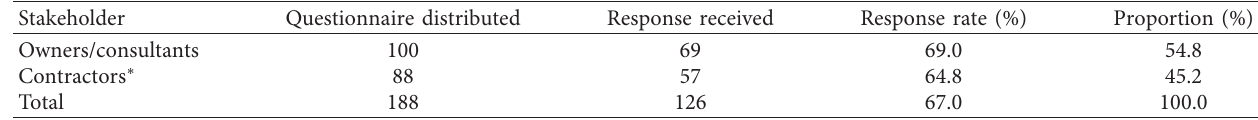
Table 2: Questionnaire return